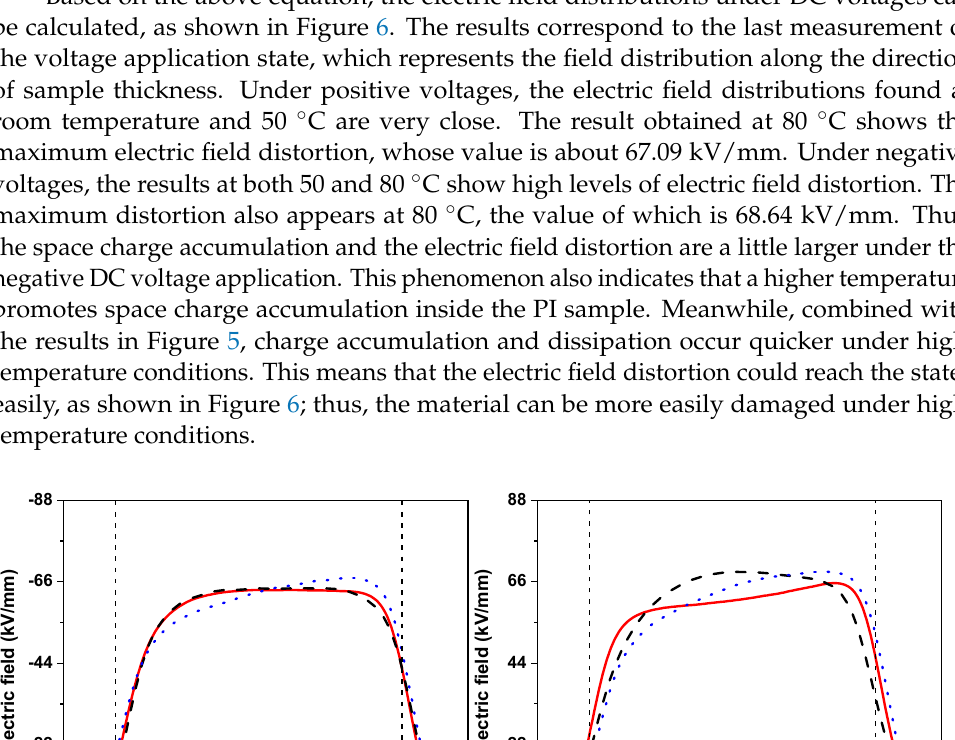
Figure 5. Space charge distributions under DC voltages: ( a ) room temperature, ( b ) 50 °C, ( c ) 80 °C.